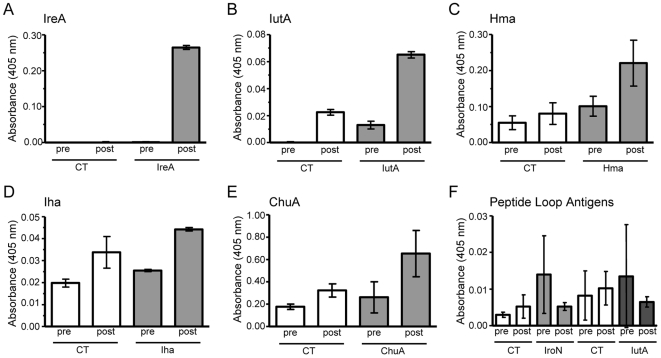
Mice produce antigen-specific urinary IgA in response to intranasal immunization.Urine from (A) IreA-vaccinated, (B) IutA-vaccinated, (C) Hma-vaccinated, (D) Iha-vaccinated, (E) ChuA-vaccinated, (F) peptide-vaccinated, and corresponding CT control mice was collected prior to vaccination (pre) and after vaccination but before transurethral challenge with UPEC strain CFT073 (post). Pooled samples were plated in appropriately coated ELISA plates and probed for antigen-specific IgA. Open bars represent CT control mice and shaded bars represent values from vaccinated mice. Absorbance reflects relative quantity of IgA. Error bars indicate the mean+/−SEM of two experiments.